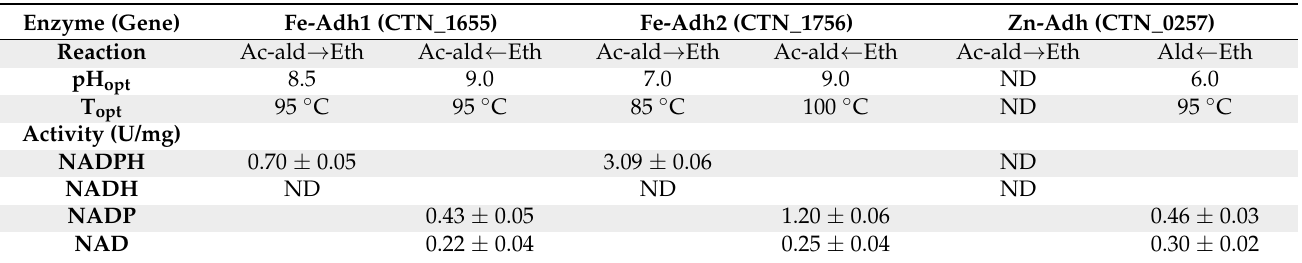
Table 1. Optimal reaction conditions and cofactor dependence for the Adhs of T. neapolitana ethanol fermentation pathway.